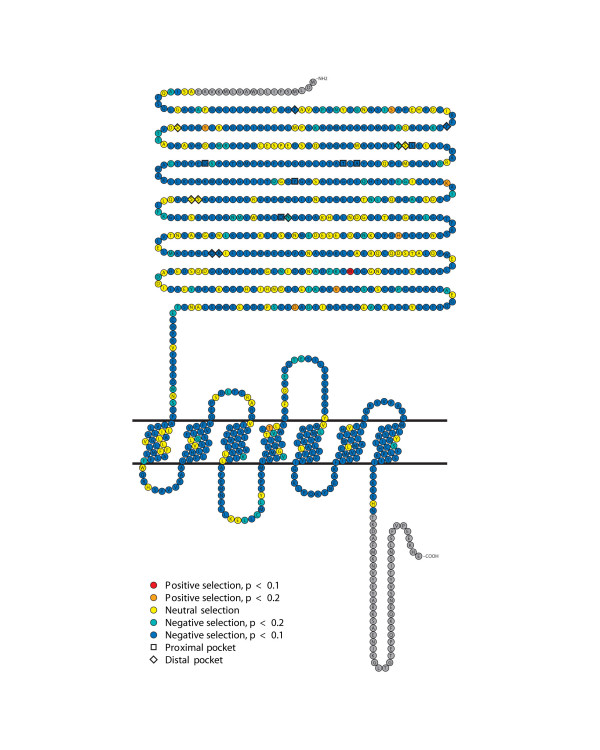
Sites under positive and negative selection in OlfC coding sequences. A schematic representation of site-by-site selective pressure is shown on the OlfCa1 receptor sequence. Nucleotide alignments were generated from the corresponding amino acid alignment [see Additional file 4]. SLAC analysis shows the probability of sites being under selective pressure (positive selection shown in red (p < 0.1) or orange (p < 0.2), neutral selection in yellow and negative selection in blue-green (p < 0.2) or blue (p < 0.1). The null hypothesis is that a site is neutrally evolving with dN/dS = 1.